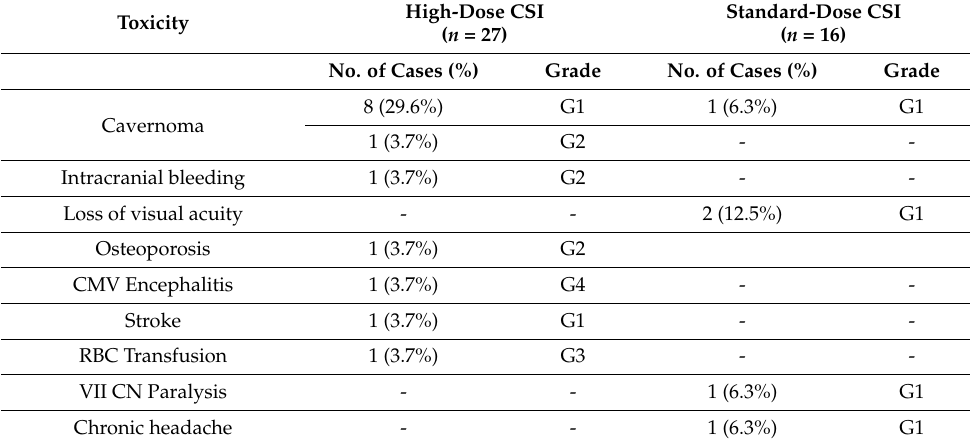
Table 7. Preliminary data on late effects attributable (at least in part) to